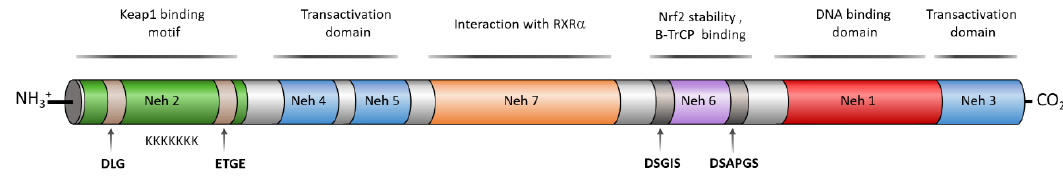
Figure 2. Human NRF2 domain structure and the activity associated to each domain. NRF2 is composed by seven Neh domains with different interaction patterns and specific activities. Neh1 presents a bZip region involved in dimerization with sMaf proteins to bind ARE regions and other transcription factors such as c-JUN, Sp-1, and JDP2 (Jun dimerization protein 2). Neh1 is also an acetylation-sensitive domain, contains an NES sequence to be exported by Crm1 and it is the target of phosphorylation by AMPK (AMP-activated protein kinase). Neh2 is a domain for degradation (degron domain) that presents the binding domain of KEAP1 and other ubiquitin ligases. KEAP1 targets the DLG and ETGE motifs each of them with different affinity. Neh 2 contains a α-helix composed by 7 Lys residues that are the targets for ubiquitination, an NLS sequence, and a serine residue (S40), that is a phosphorylation target of PKCδ, and both motifs are related to NRF2 nuclear translocation. The Neh3 domain contains another NLS sequence and two Lys residues that are targets for acetylation related to nuclear translocation. Neh4 and Neh5 are transactivation domains involucrate in the binding of CBP, P300, Hrd1, and RAC3 to NRF2. Neh6 contains a second degron domain targeted by β-transducing repeat-containing protein (β-TrCP) by interaction with the DSGIS motif, after being phosphorylated by GSK-3β and the DSAPGS motif. Finally, Neh7 is a repressor domain targeted by RXRα.